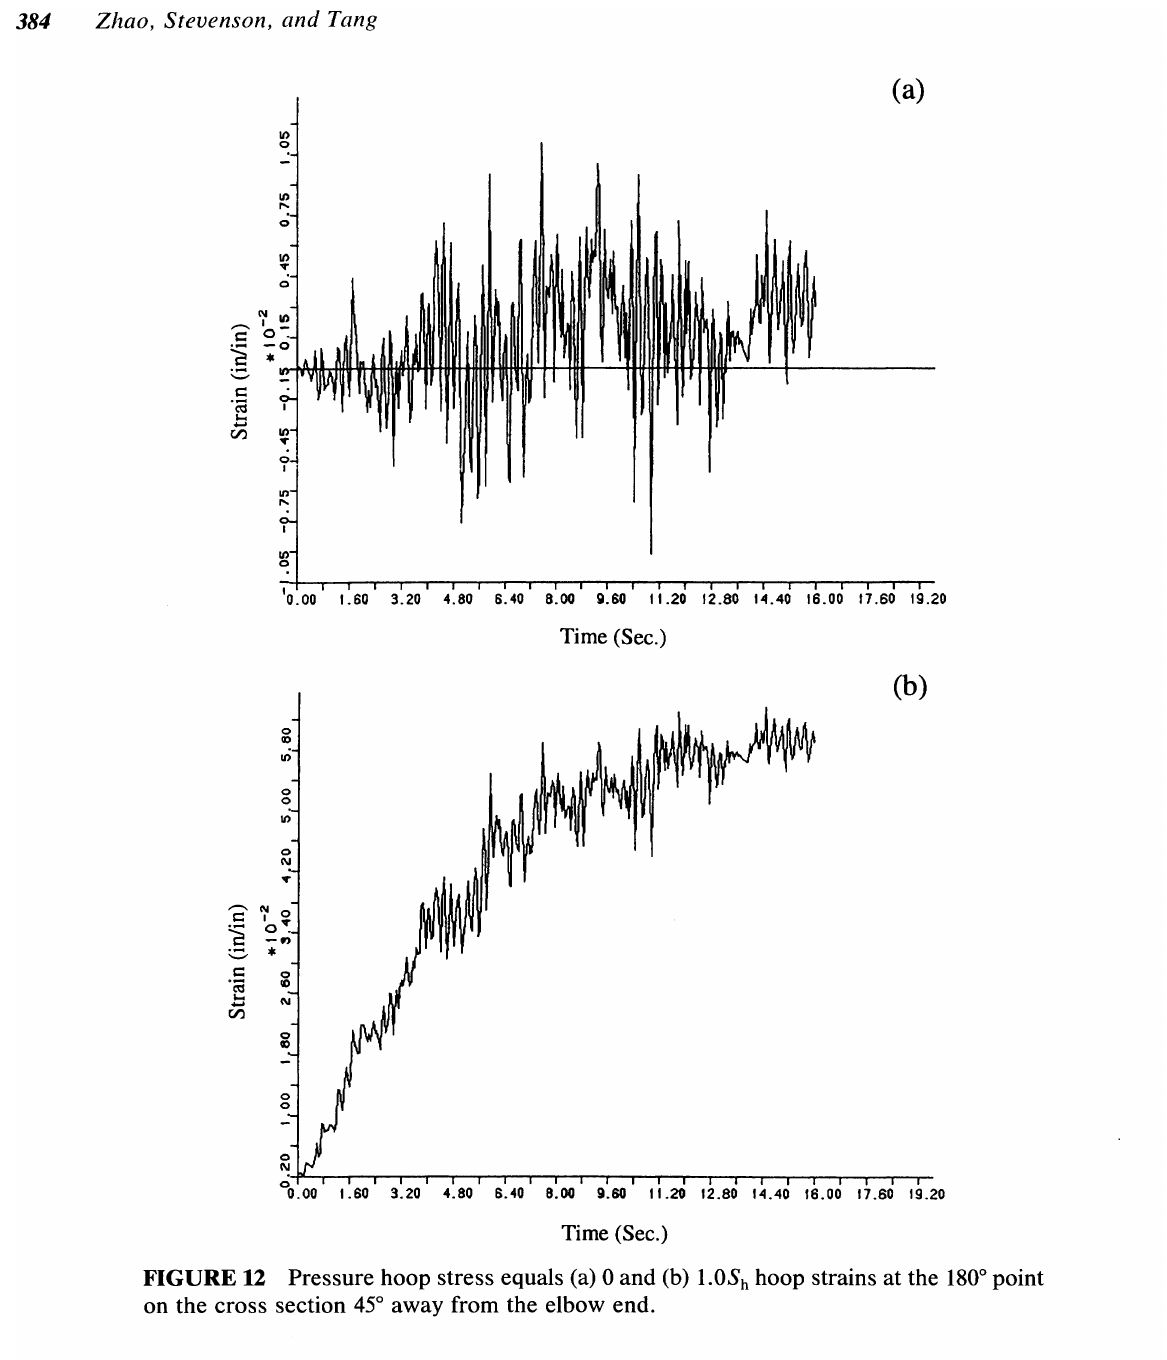
FIGURE 12 Pressure hoop stress equals (a) 0 and (b) LOS h hoop strains at the 180 0 point on the cross section 45 0 away from the elbow